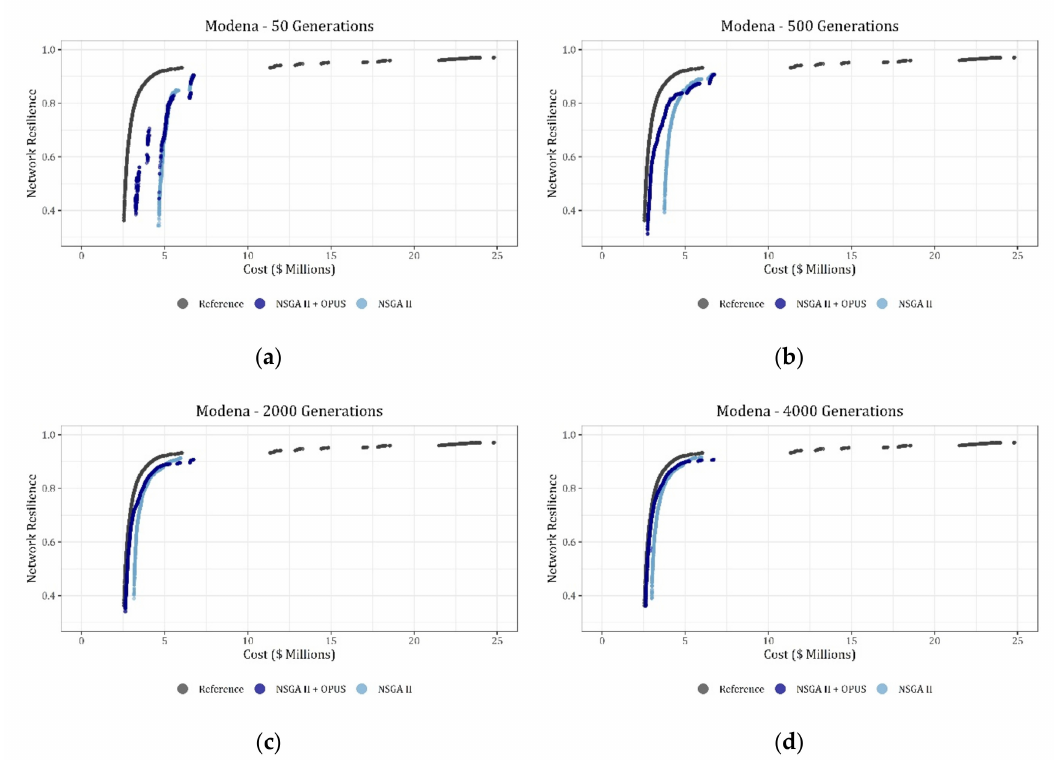
Figure 4. Evolution of the PFs for the NSGA-II algorithm (light blue) and the retrofitted NSGA-II